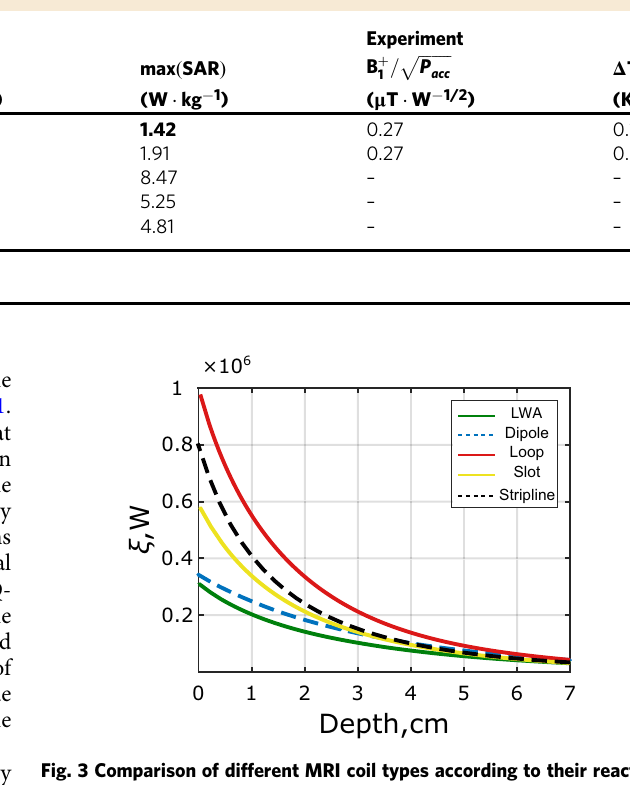
Table 1 Numerically simulated results of the B þ human body phantom.